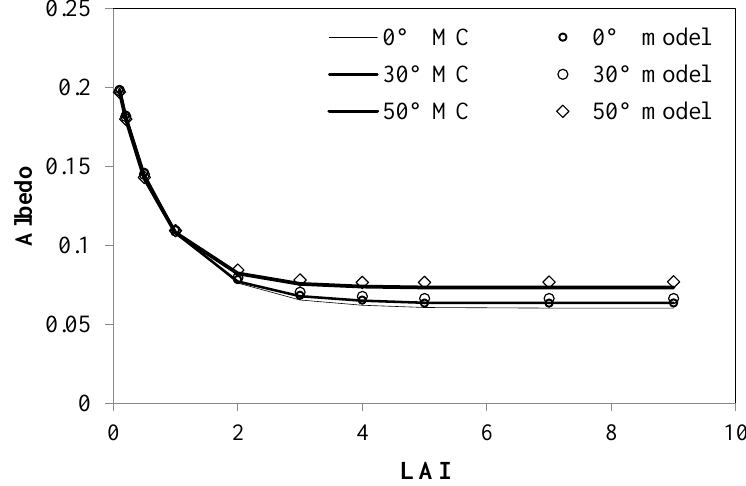
Figure 10. Relationships between LAI and black-sky albedo (BSA) as predicted by the model (circles and diamonds) and MC (solid lines) under different solar zenith angles (SZA, deployed at 0°, 30° and 50°) at the green band (530 nm). The difference in the width of lines and the size of markers shows the variation on SZA.